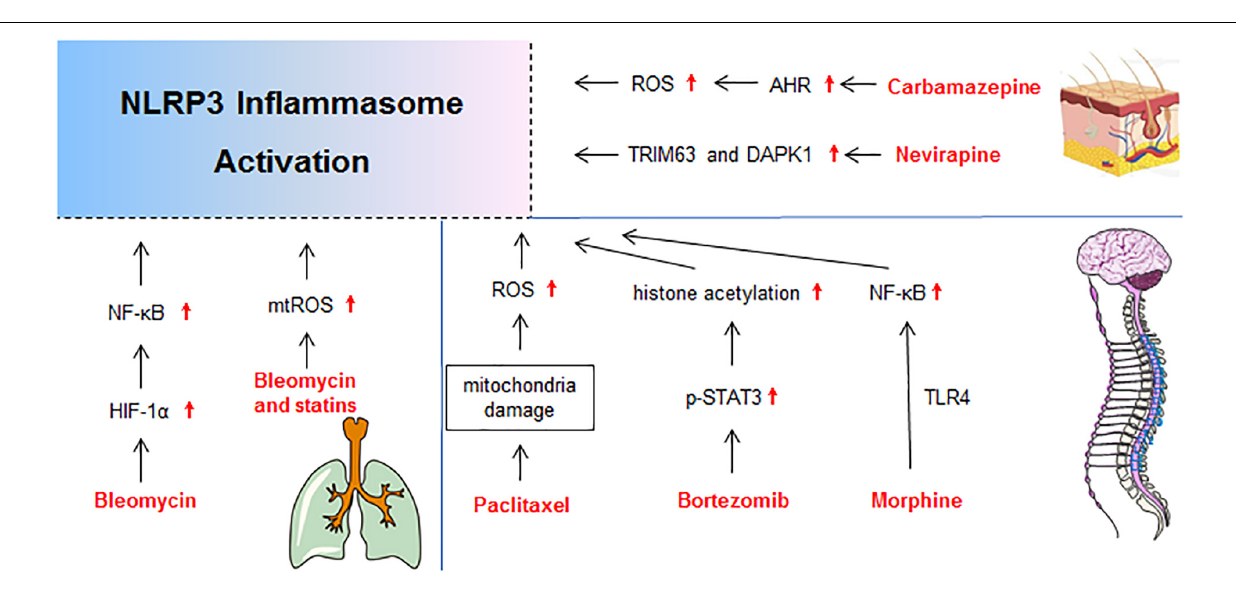
mechanisms of NLRP3 activation in DILI are summarized in Figure 2 . Acetaminophen-Induced Liver Injury Acetaminophen (N-acetyl- p -aminophenol, also known as paracetamol) is a widely used safe antipyretic and analgesic drug. However, acetaminophen overdose is the most frequent cause of acute liver failure in the United States and